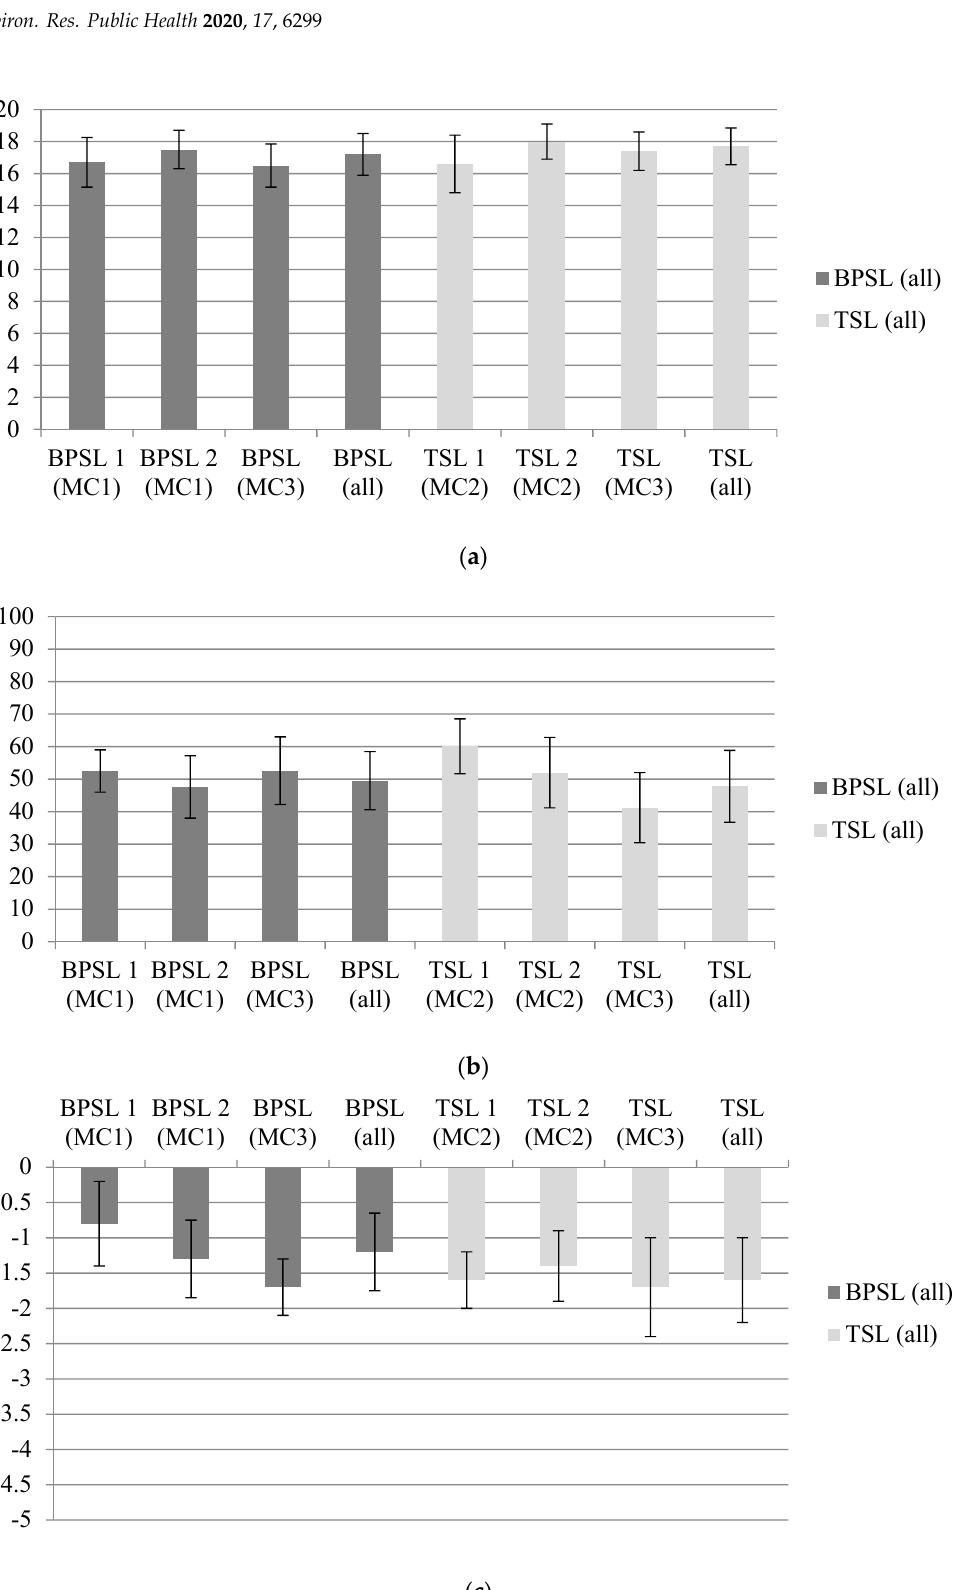
Figure 3. Comparison of acceptability by meal type: ( a ) total taste test score; ( b ) average total plate waste; ( c ) change in hunger. There were no significant differences between meal types for total taste test score, average total plate waste, and changes in hunger after adjusting for sex, grade level, BMI percentile, and group ( ps > 0.017). MC = meal condition. Max scores: total taste test score = 20 points, average total plate waste = 100%, change in hunger = 5 points from pre- to post-meal consumption. Error bars = standard deviation.